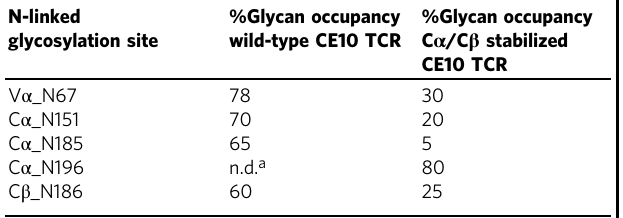
Table 2 Glycan occupancy of the CE10 TCR in the absence and presence of the stabilizing C α /C β designs. Occupancy was determined based on chromatography peak area of occupied/unoccupied peptides (e.g., Fig.